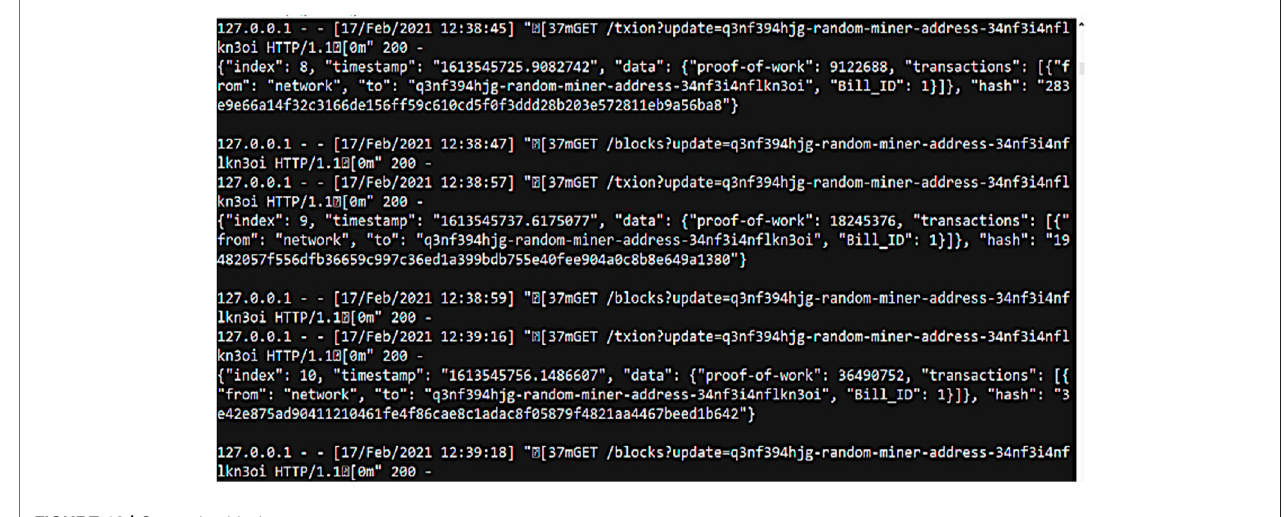
FIGURE 12 | Generating blocks.